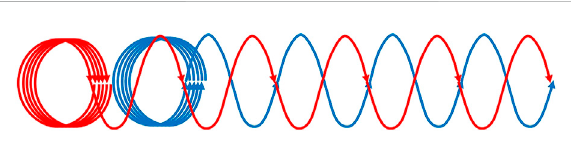
FIGURE 5 Close-up of quark segments of opposite chirality (blue and red coils) unwinding, i.e., annihilating into a ray of co-propagating photonswithoppositephases(blueandredwaves).Astheemitted pairs of photons are without net electromagnetic fi elds, they are detectable only through their energy density relative to the surrounding vacuum density, e.g., through interference